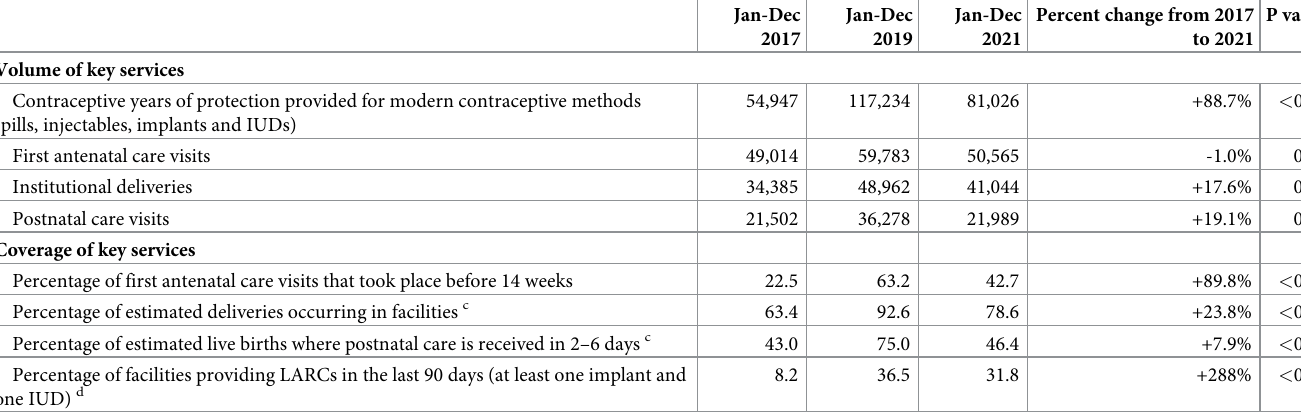
Table 6. Service delivery volumes and coverage a